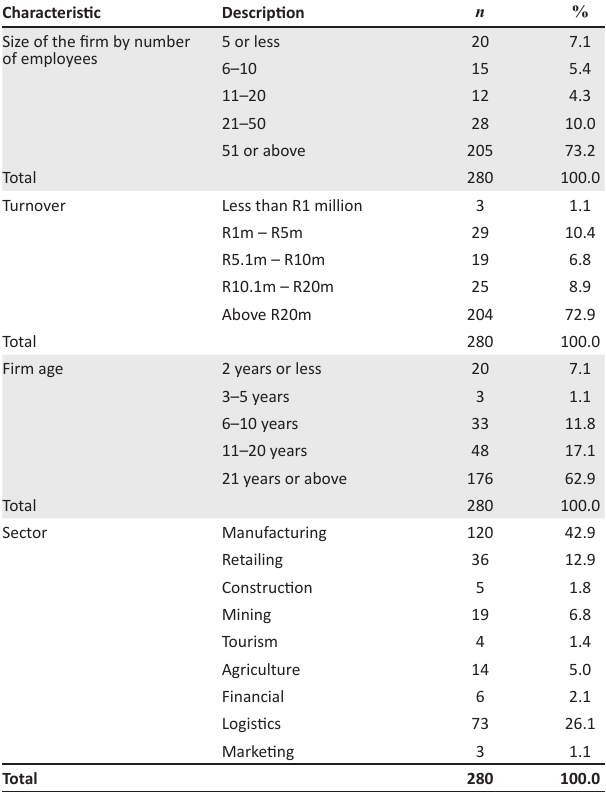
TABLE 1: Sample profile. Characteristic